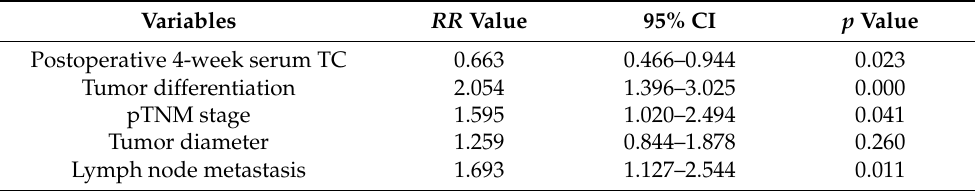
Table 8. Multivariate analysis of postoperative long-term survival in pancreatic cancer